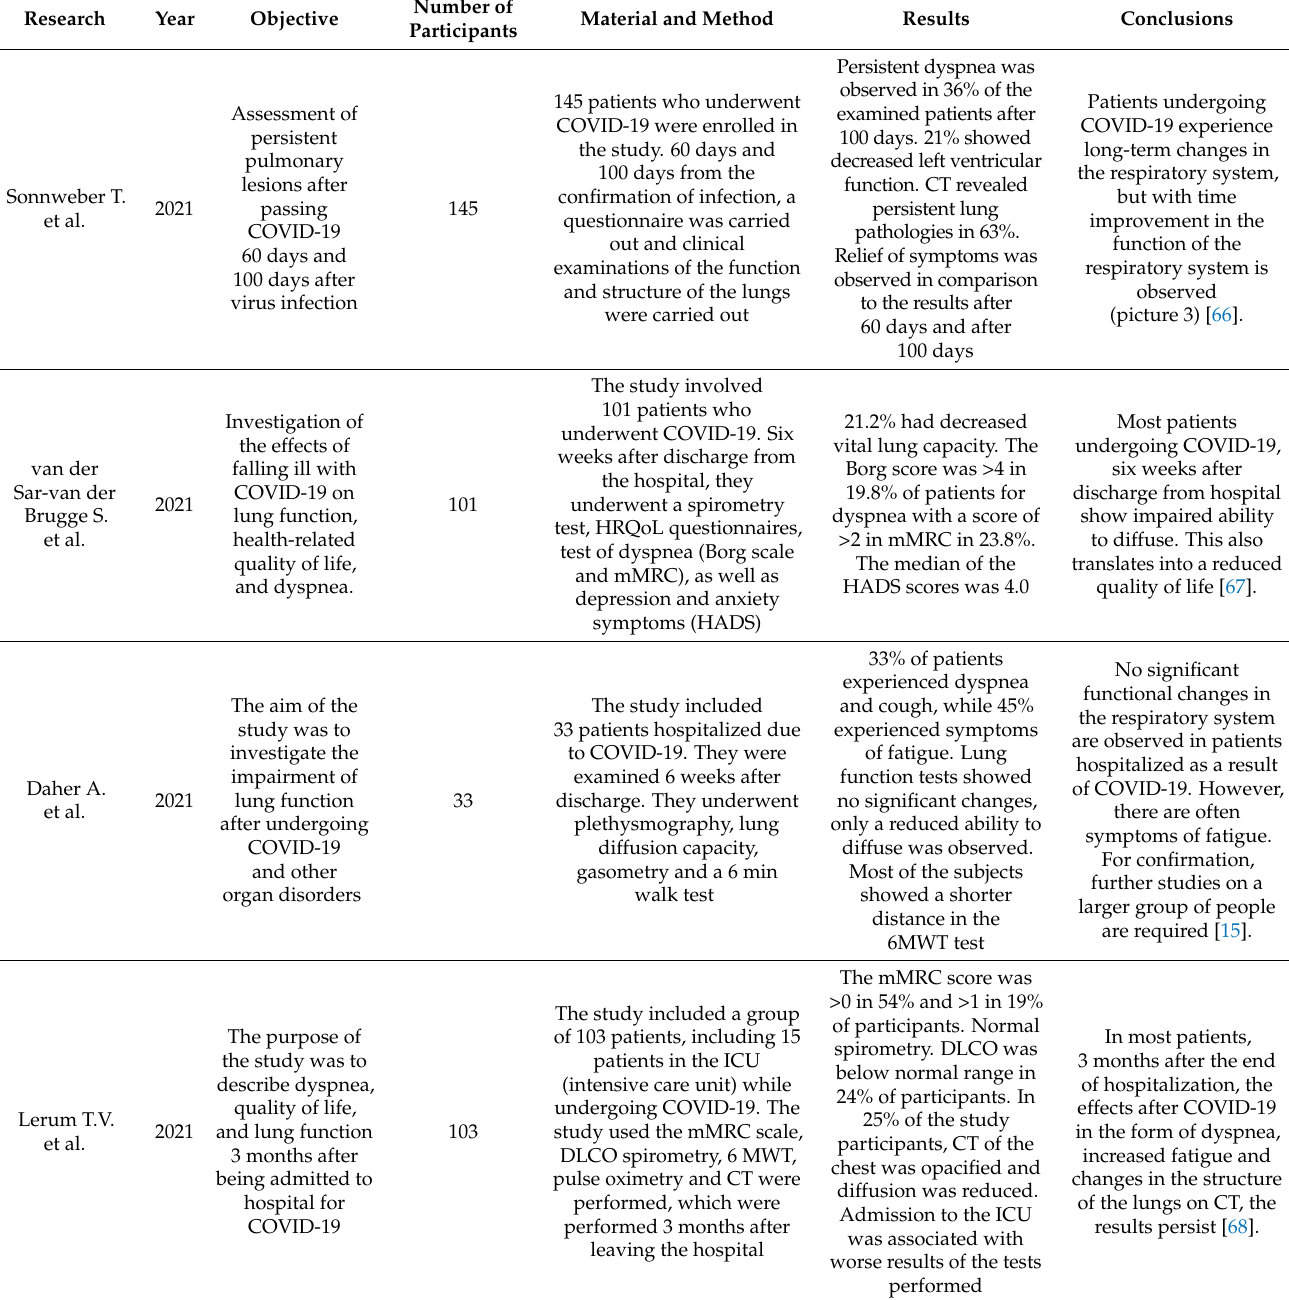
Table 4. The main effects of COVID-19 on the respiratory